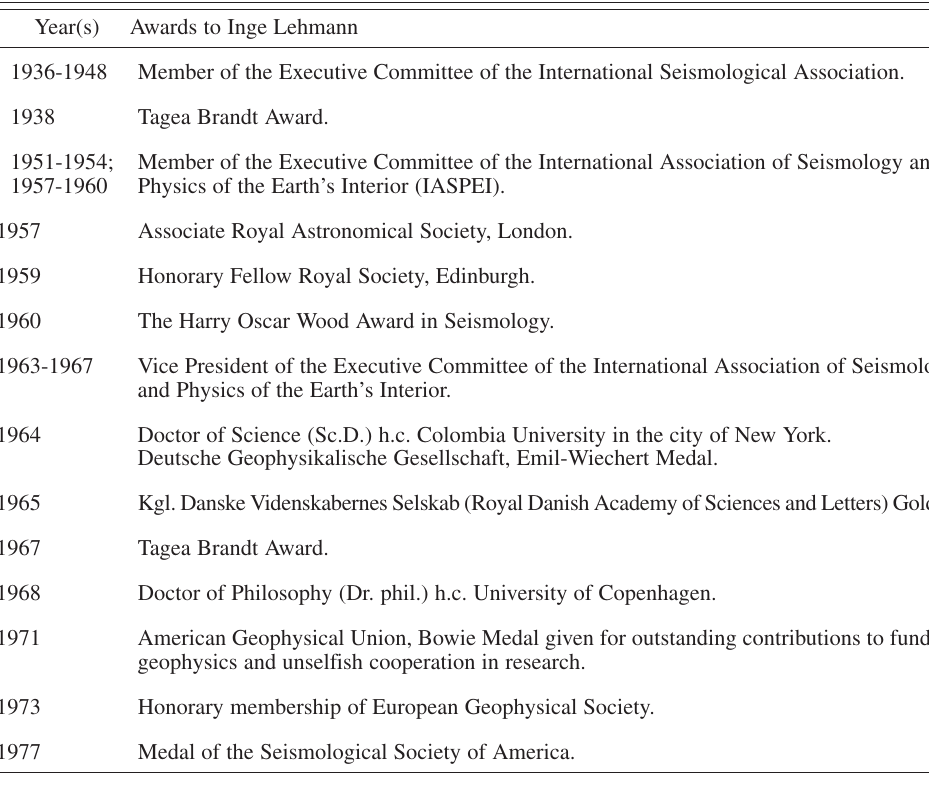
Table II. Inge Lehmann’s many